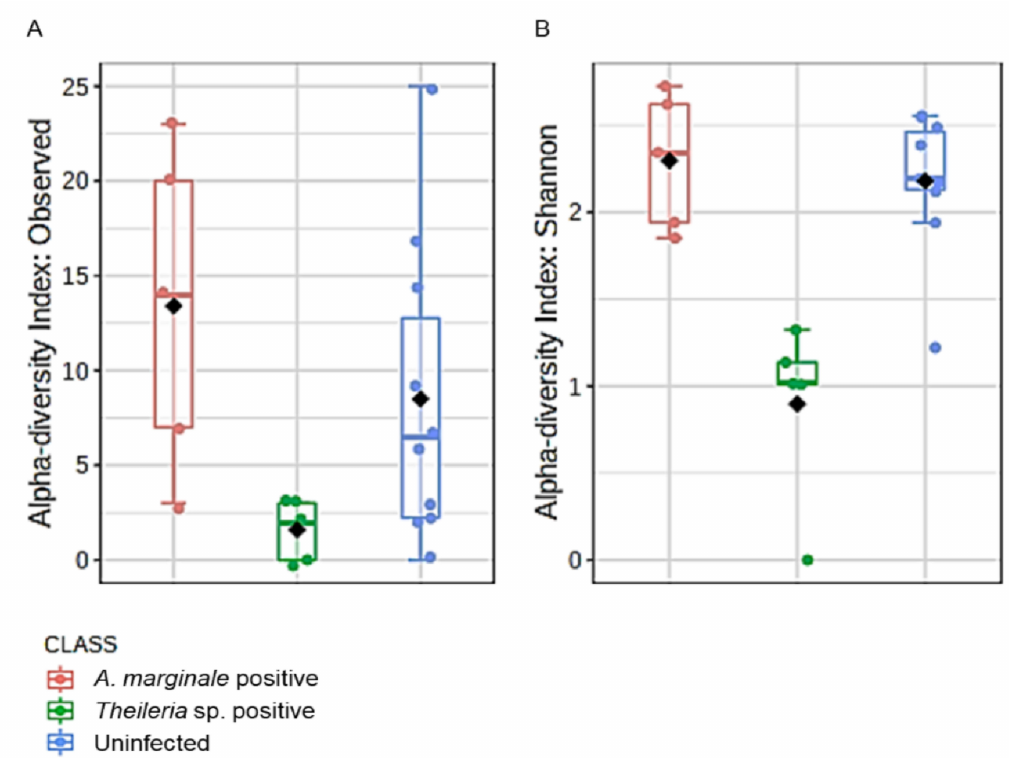
Figure 3. Alpha diversity analysis in R. microplus ticks. ( A ) Estimation of species richness using the observed operational taxonomic (OTUs) metrics (Kruskal–Wallis H-test, df = 1, p -value = 0.003). ( B ) Estimation of species evenness using the Shannon diversity index (Kruskal–Wallis H-test, df = 1, p -value = 0.005). Ticks found to be positive for Theileria sp. showed the least diversity